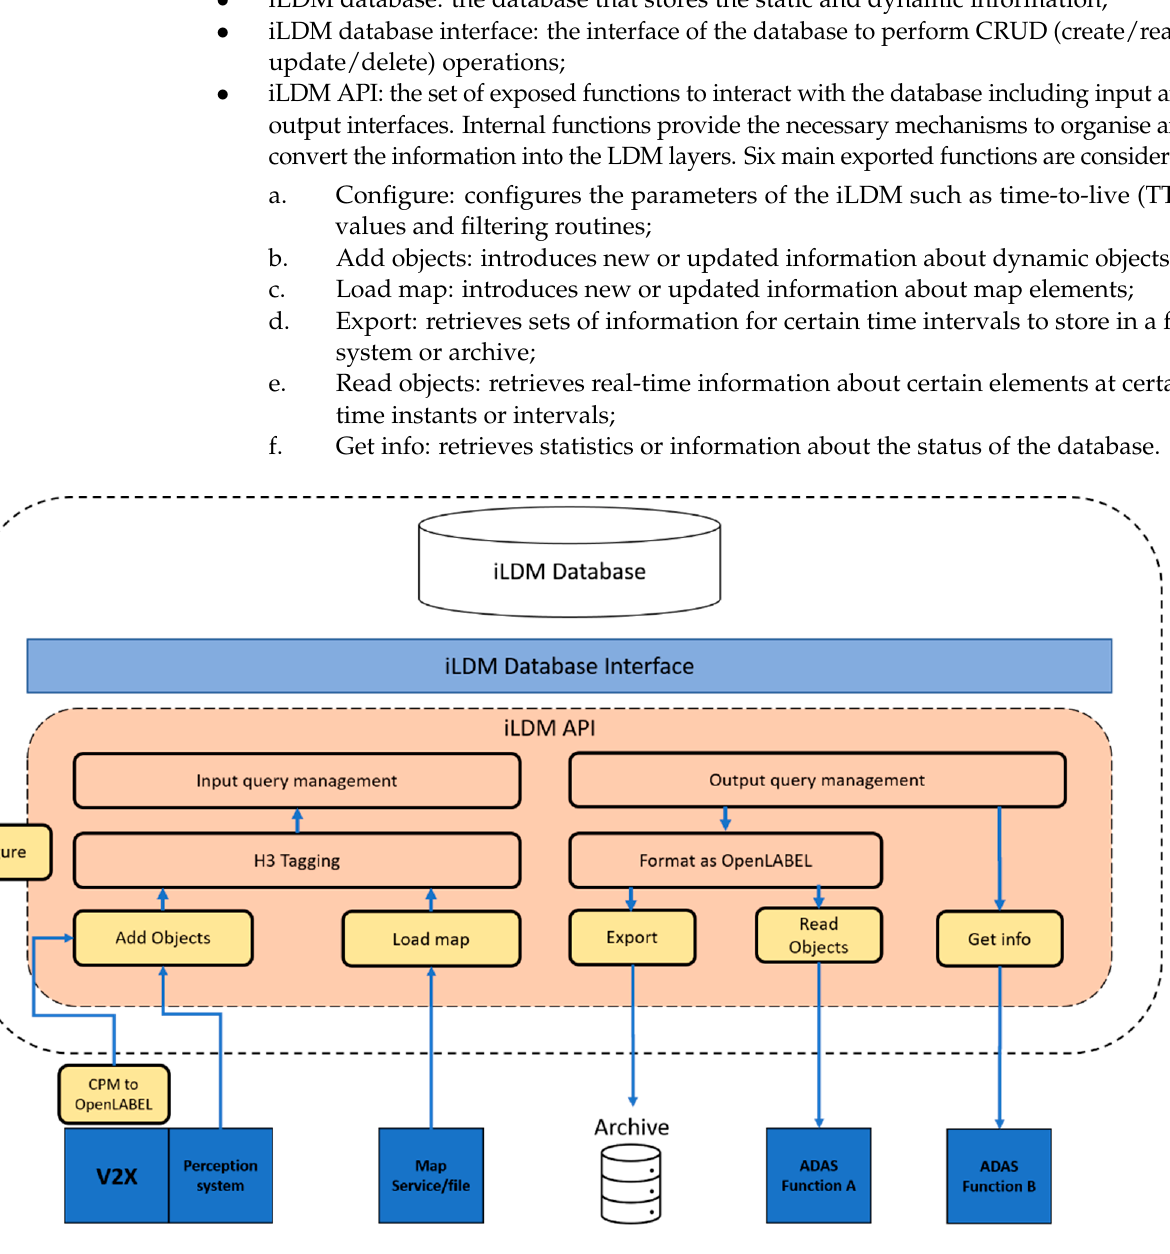
Figure 2. Functional architecture of the iLDM component.